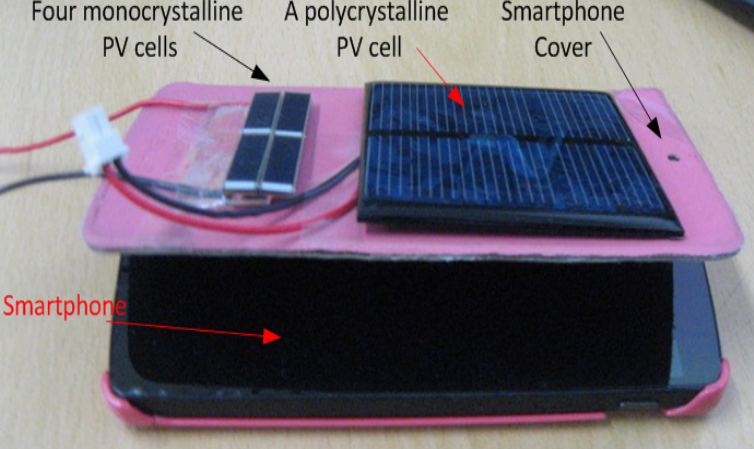
Figure 8. The experiential platform for charging the small Li-Ion 3.7 V battery for emergency backup, using PVs on a smartphone cover.